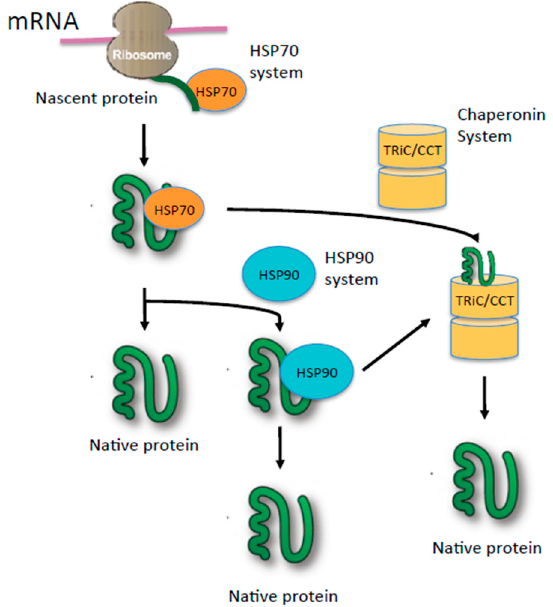
Figure 1. Model of the chaperone network involving HSP70, HSP90, and TRiC (T-complex protein-1 ring complex, also known as CCT). Newly synthesized nascent polypeptide chain interacts with the HSP70 family, which mediates folding either co-translationally or post-translationally. HSP70 also can deliver a folding-intermediate to downstream chaperones HSP90 or TRiC/CCT to complete folding.